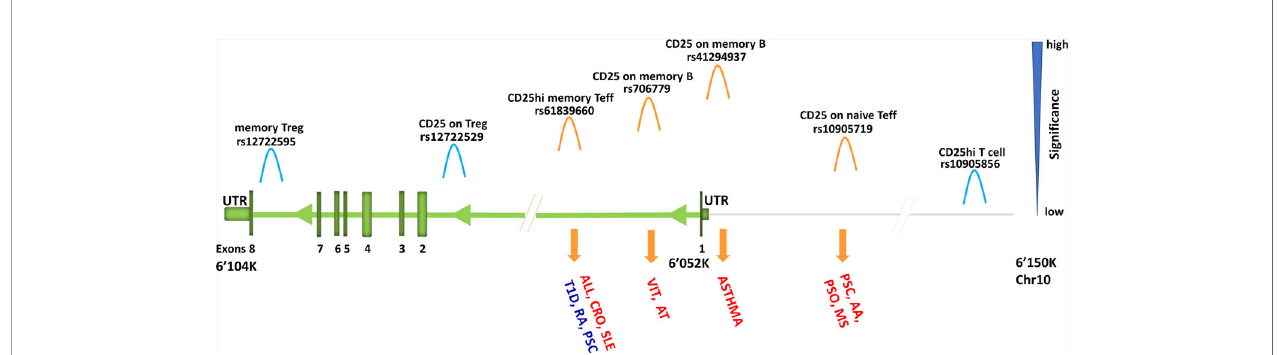
FIGURE 6 | Association signals at IL2RA region. Representation of IL2RA gene (green) and about 100 kb upstream to the gene (grey line). The association signals with immune cell traits are depicted by «hills» which are colored in orange or light blue if overlapping or not overlapping with disease-association signals, respectively. Disease is in red if the predisposing allele is associated with increase of immune cell traits, whereas it is in blue if the predisposing allele is associated with decrease of immune cell traits. Disease acronyms: T1D, type one diabetes; RA, rheumatoid arthritis; PSC, primary sclerosis cholangitis; ALL, allergy; CRO, Crohn ’ s disease; SLE, systemic lupus erythematosus; VIT, vitiligo; AT, autoimmune thyroiditis; AA, alopecia areata; PSO, psoriasis; MS,